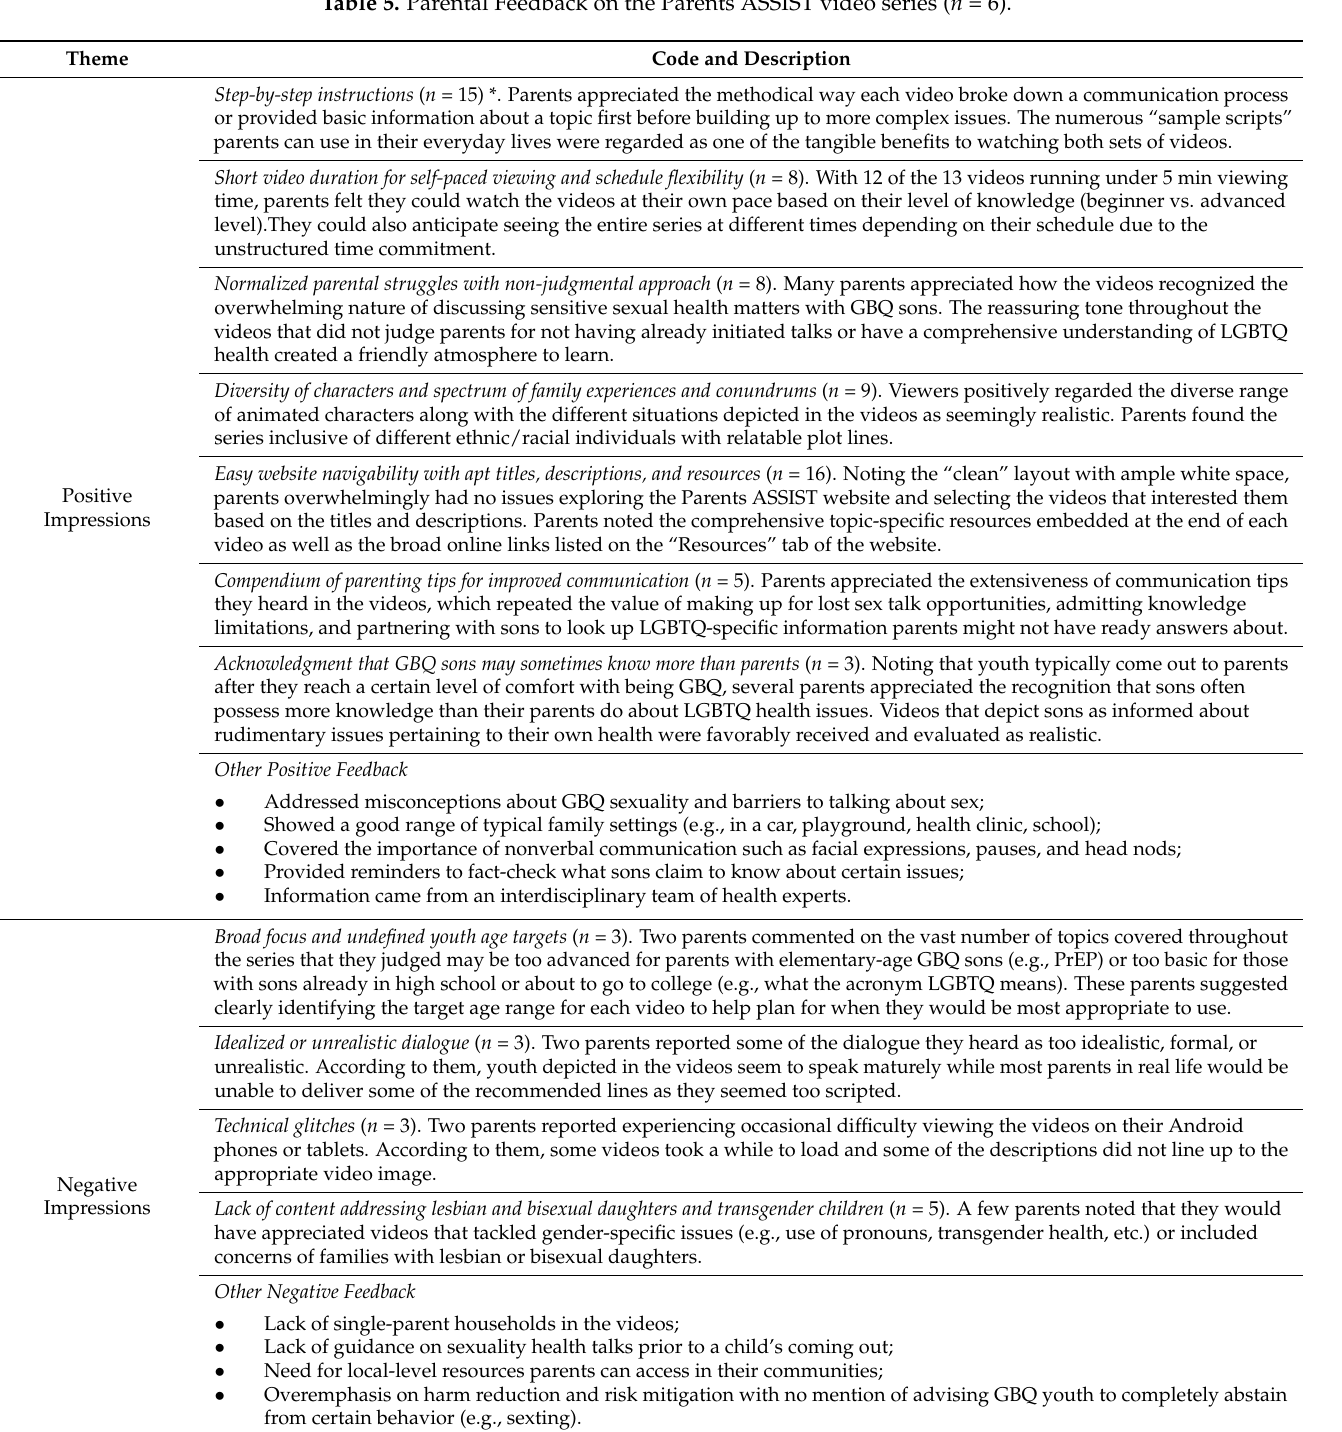
Table 5. Parental Feedback on the Parents ASSIST video series ( n =